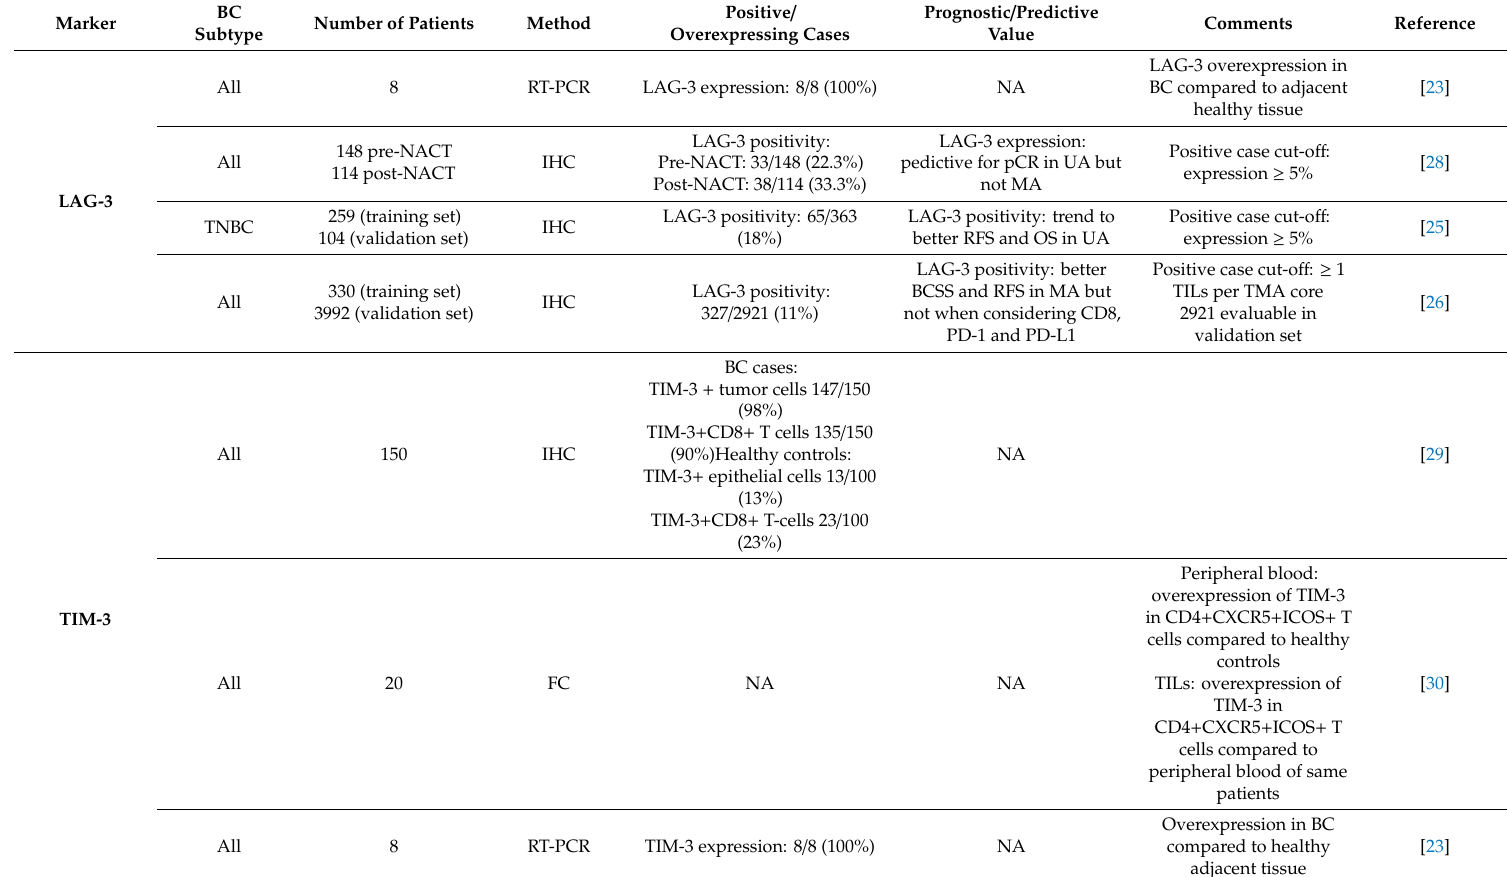
Table 1. Expression and prognostic / predictive value of immune-related markers predominantly expressed on